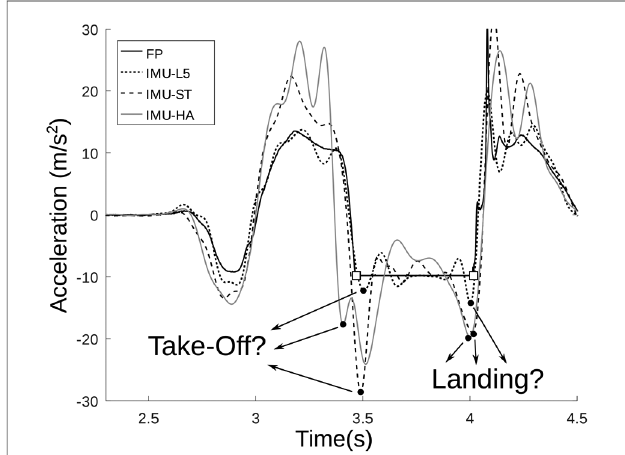
FIGURE 1 Example of vertical acceleration during CMJ, measured at different positions and instrumentations. Legend: Force Platform gold standard (continuous line, FP); IMU at L3-L5 vertebrae (dotted line, IMU-L5); IMU attached close to the sternum (dashed line, IMU-ST); IMU placed within the hands (gray continuous line, IMU-HA) resembling the con fi guration used in the study; the square markers identify the actual take-off and landing instants on the FP signal. IMU signals were low-pass fi ltered (Butterworth, 6th order, f c ¼ 10Hz). It is possible to appreciate the wide variability of the key time instants (take-off and landing) depending on the sensor position. The depicted data were acquired through Vicon Nexus software using Vicon Blue-Trident IMUs (Vicon, Oxford, United Kingdom; sampling frequency: 1,000 sample/s; full scale range: accelerometer ¼ + 16g, gyroscope ¼ +